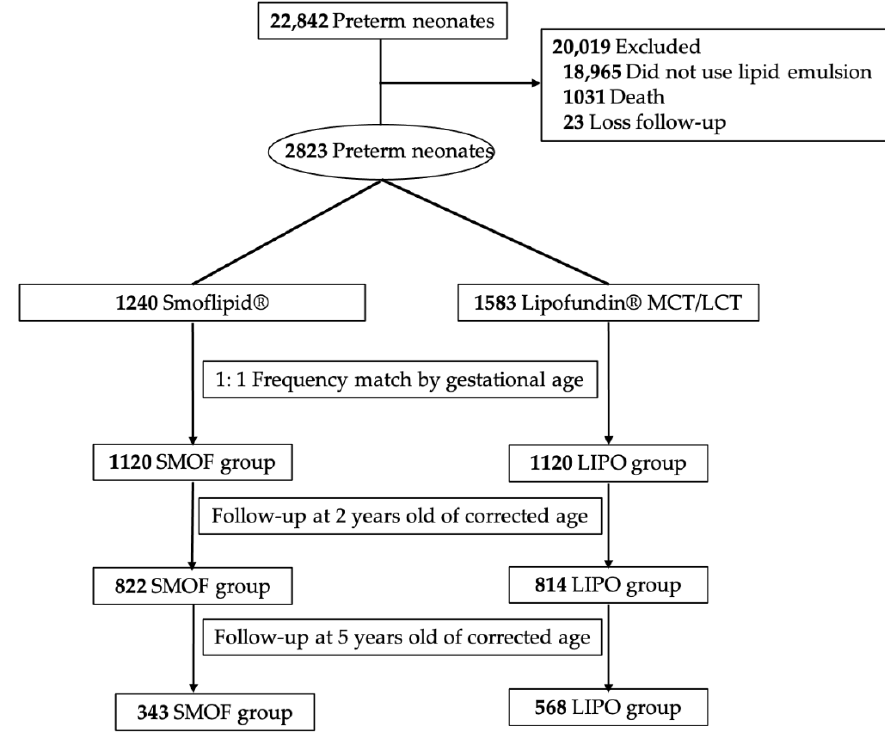
Figure 1. Flow chart of included and excluded patients.